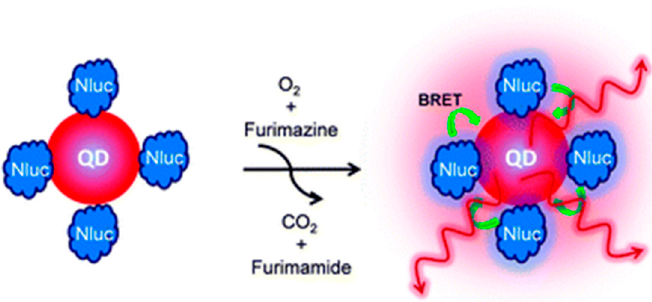
Figure 6. QD-Nluc-cRGD conjugate. Chemical communications by Royal Society of Chemistry (Great Britain) Reproduced with permission of ROYAL SOCIETY OF CHEMISTRY in the format Journal/magazine via Copyright Clearance Center.